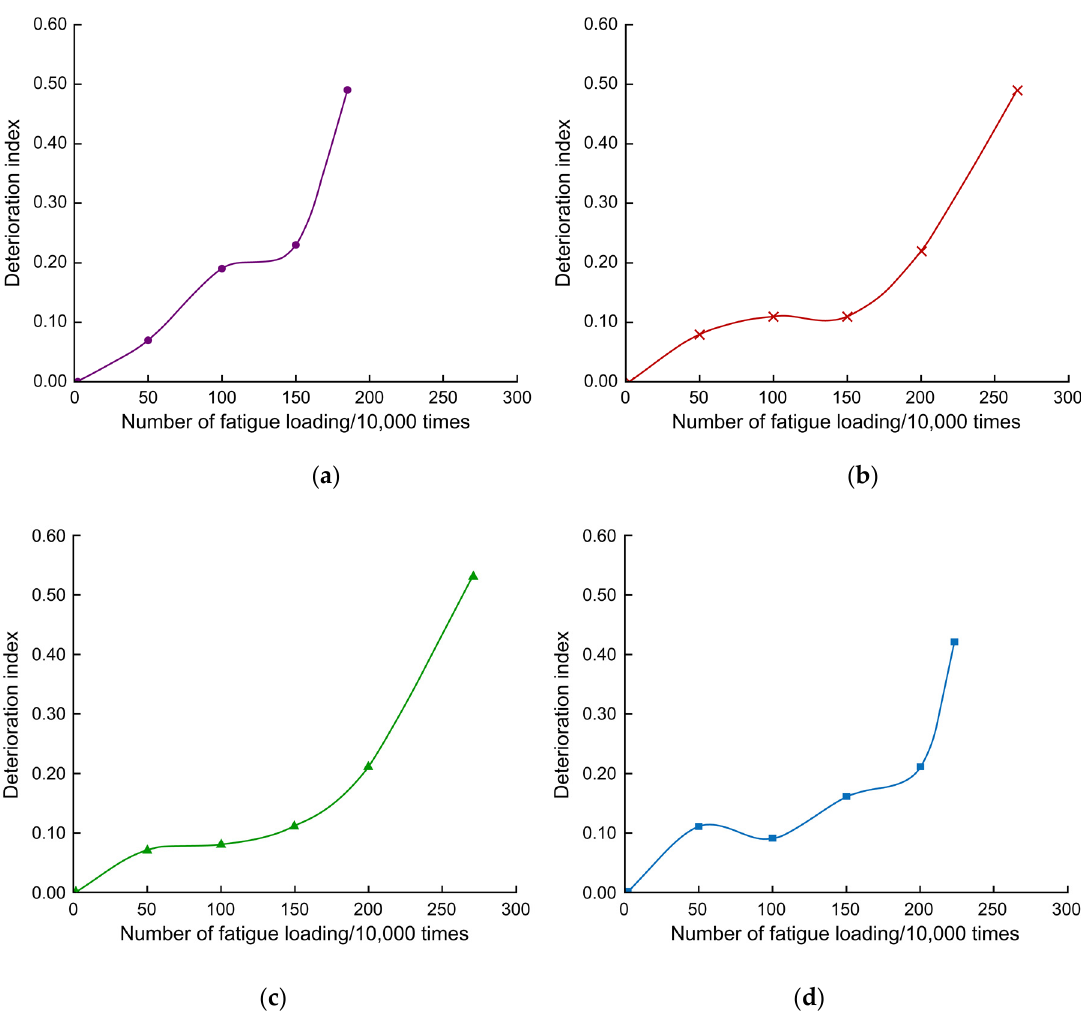
Figure 17. D i –N curves ( a ) PL2, ( b ) PL3, ( c ) PL4, and ( d )